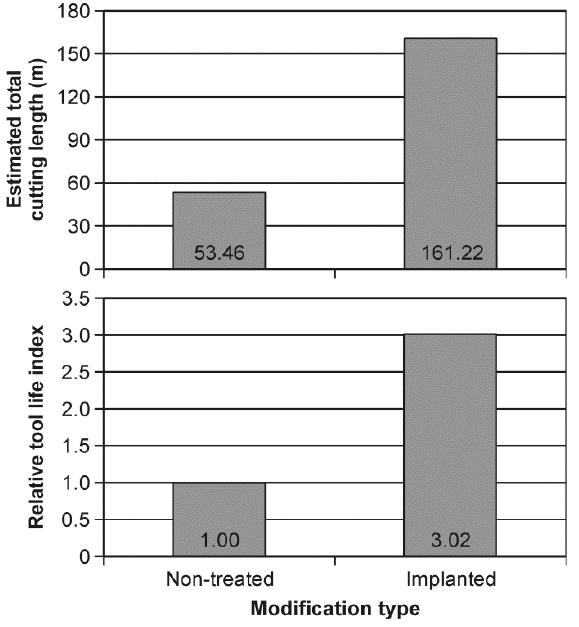
Figure 10. Estimated total cutting length and the relative tool life index for non-treated and ion-implanted circular saw blades.